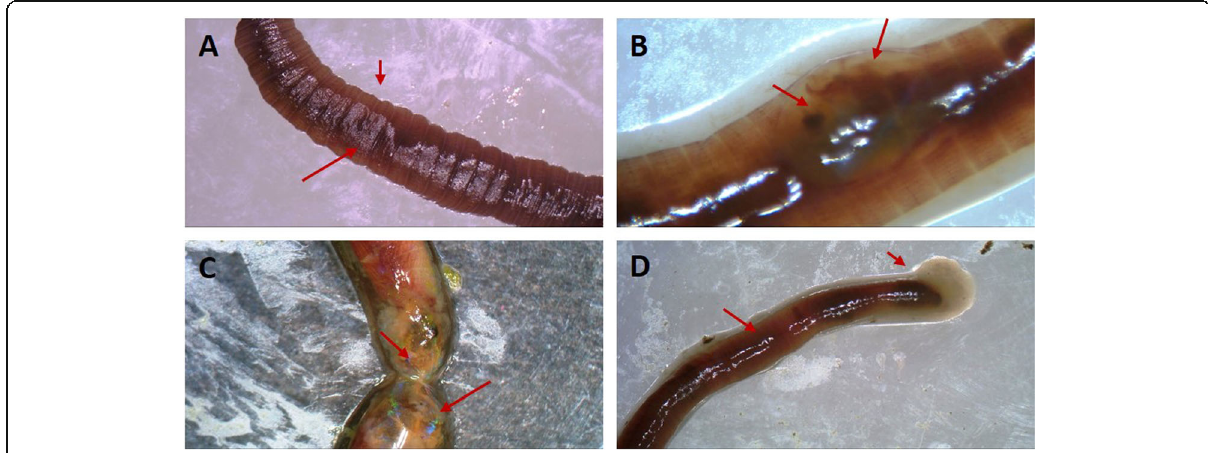
Fig. 8 Anatomical and morphological aberrations caused by extract on Pheretima posthuma . a : Normal Anatomy; b : Treated samples displaying muscular contraction; c : Treated samples showing coelomic fluid leakage; d : Treated samples showing high degree of endothermal ablation